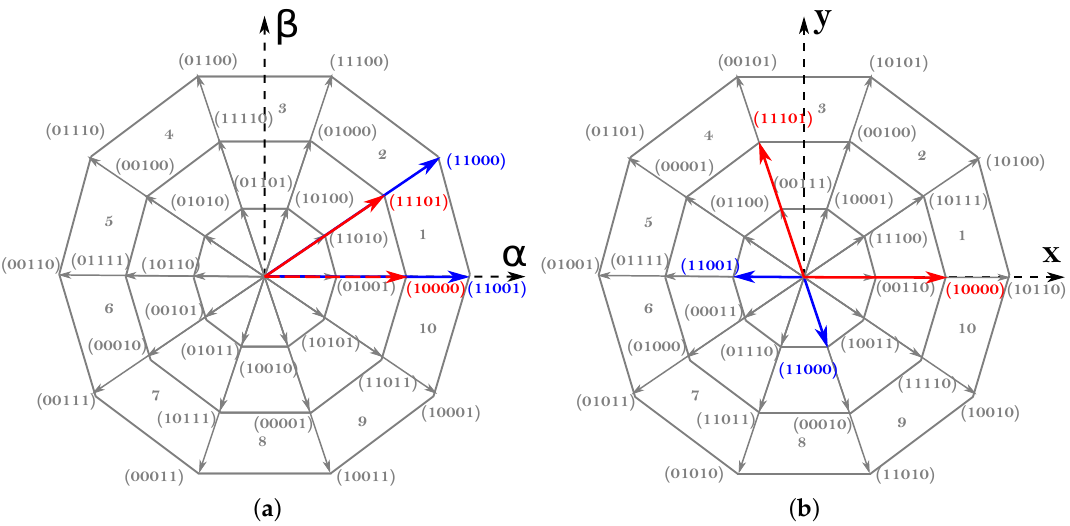
Figure 3. Five-phase SV-PWM: α - β and x - y planes with their corresponding space vectors and switching states (a ‘1’ in a switching state represents that the top switch of a given phase is activated, while a ‘0’ represents that its complementary switch is activated). ( a ) α - β vector plane. ( b ) x - y vector